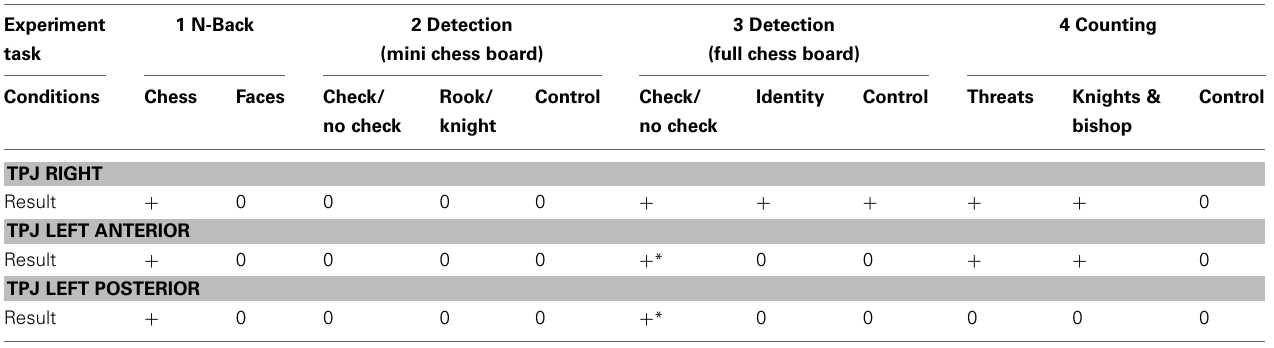
Table 2 | Results of statistical comparisons between experts and novices are indicated by a ‘ + ’ if a significant difference for the respective experiment and factor combination was observed and ‘0’ if the difference was not significant.